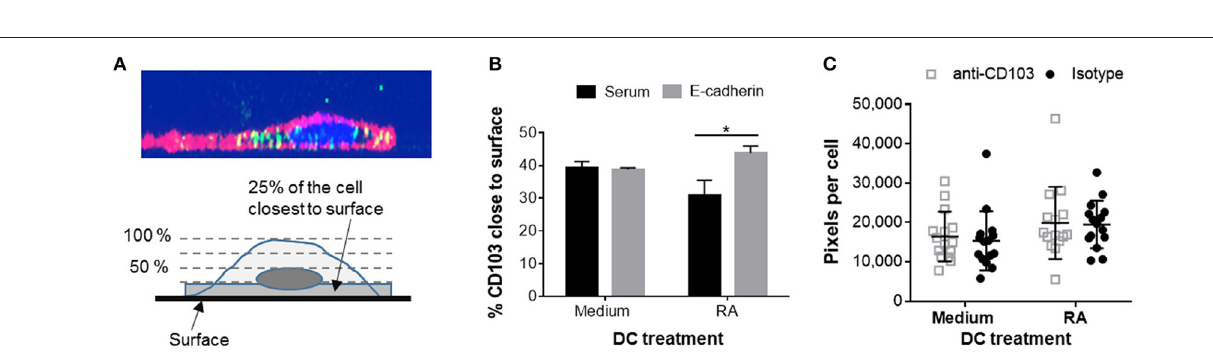
FIGURE 6 | Adhesion of RA-treated MoDCs to E-cadherin-coated surfaces alters distribution of CD103. DC interactions with E-cadherin were analyzed by performing adhesion and spreading assays on glass slides coated with recombinant human E-cadherin. (A,B) RA-treated and untreated MoDCs were added to E-cadherin-coated slides and were incubated at 37 ◦ C for 40min. Cells were then fixed, permeabilized and stained for CD103 expression. Z-stack images (0.5 µ m step size) of adherent MoDCs were collected by confocal microscopy and analyzed for the distribution of CD103 in relation to the glass surface. (A) Top panel: orthogonal representation of an immunofluorescently labeled MoDC adhered to a glass surface and analyzed by z-stack confocal imaging. CD11c: red, CD103: green, DAPI nuclear stain: blue. Bottom panel: graphical representation of the image analysis approach. (B) Summarized data from three independent experiments were analyzed. * P ≤ 0.05, 1-way ANOVA with Tukey’s post-hoc test. (C) Spreading analysis of DCs on E-cadherin-coated glass slides. Glass slides were first coated with anti-human IgG antibodies and then with recombinant human E-cadherin-Fc. MoDCs generated in the presence of medium alone or 100nM RA were pre-treated with a CD103 neutralizing antibody or an isotype control antibody for 30min at 4 ◦ C. Cells were then added to the slides in the presence of 2mM Mn 2 + and incubated at 37 ◦ C for 40min. Cell spreading was analyzed by fluorescence microscopy based on HLA-DR + pixels per nucleus. Individual data points ( n = 15 areas), mean and SEM from one representative out of 3 independent experiments are